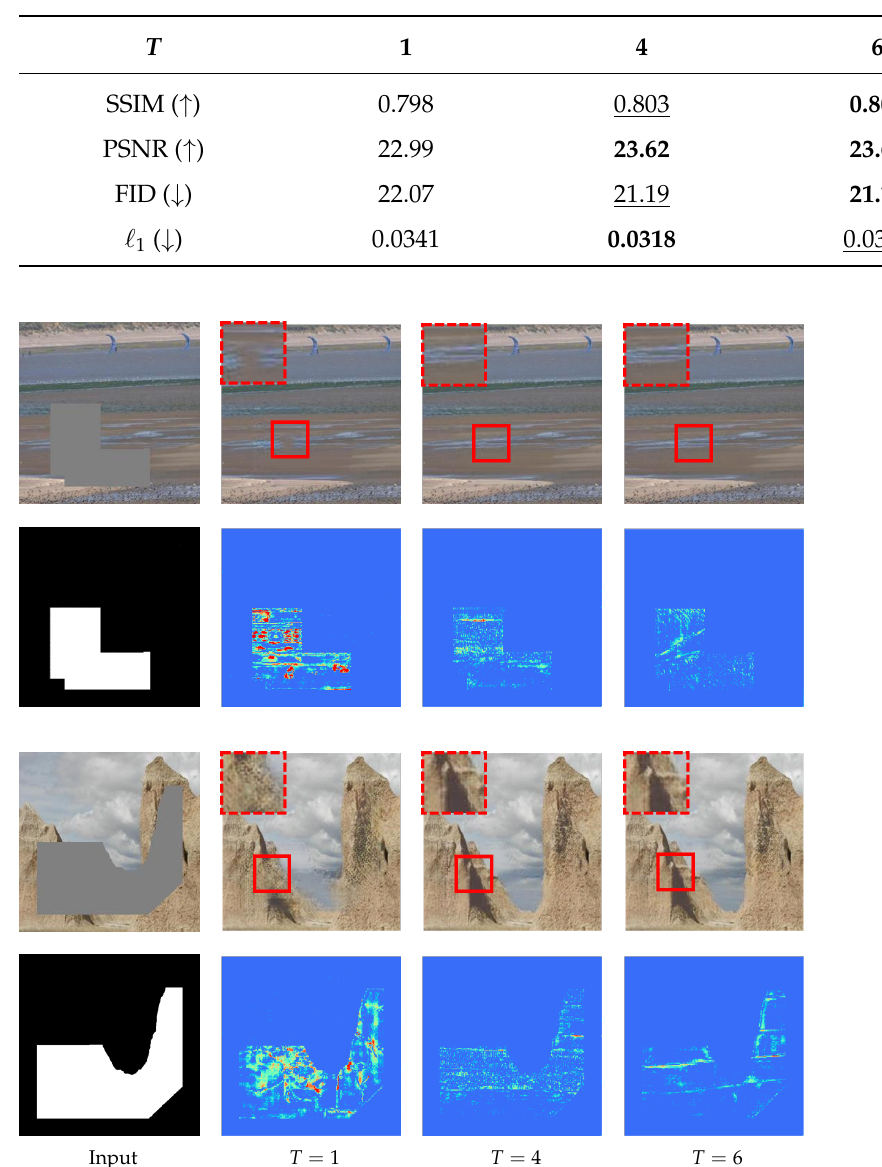
Table 3. Quantitative results for the ablation study on the number of inpainting stages.